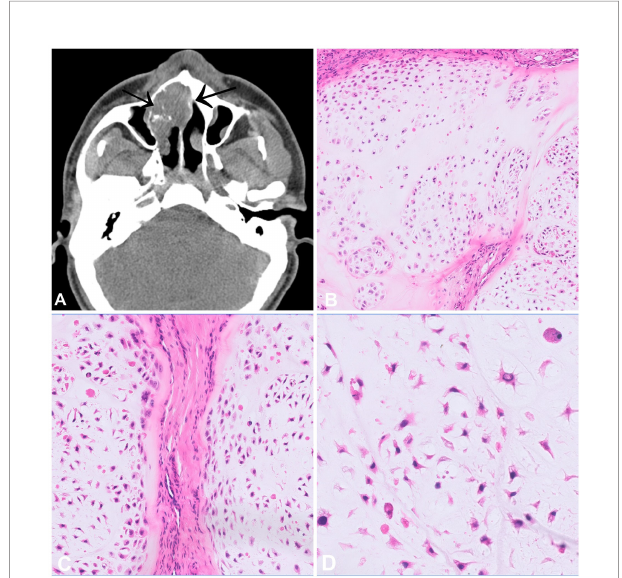
FIGURE 1 | Chondrosarcoma. (A) CT scan of a high-grade chondrosarcoma arising from the nasal septum with focal mineralisation. (B – D) Grade 2 chondrosarcoma showing increase in cellularity when compared to a chondrosarcoma grade 1. The cells have atypical, hyperchromatic nuclei and are set in a hyaline matrix with myxoid